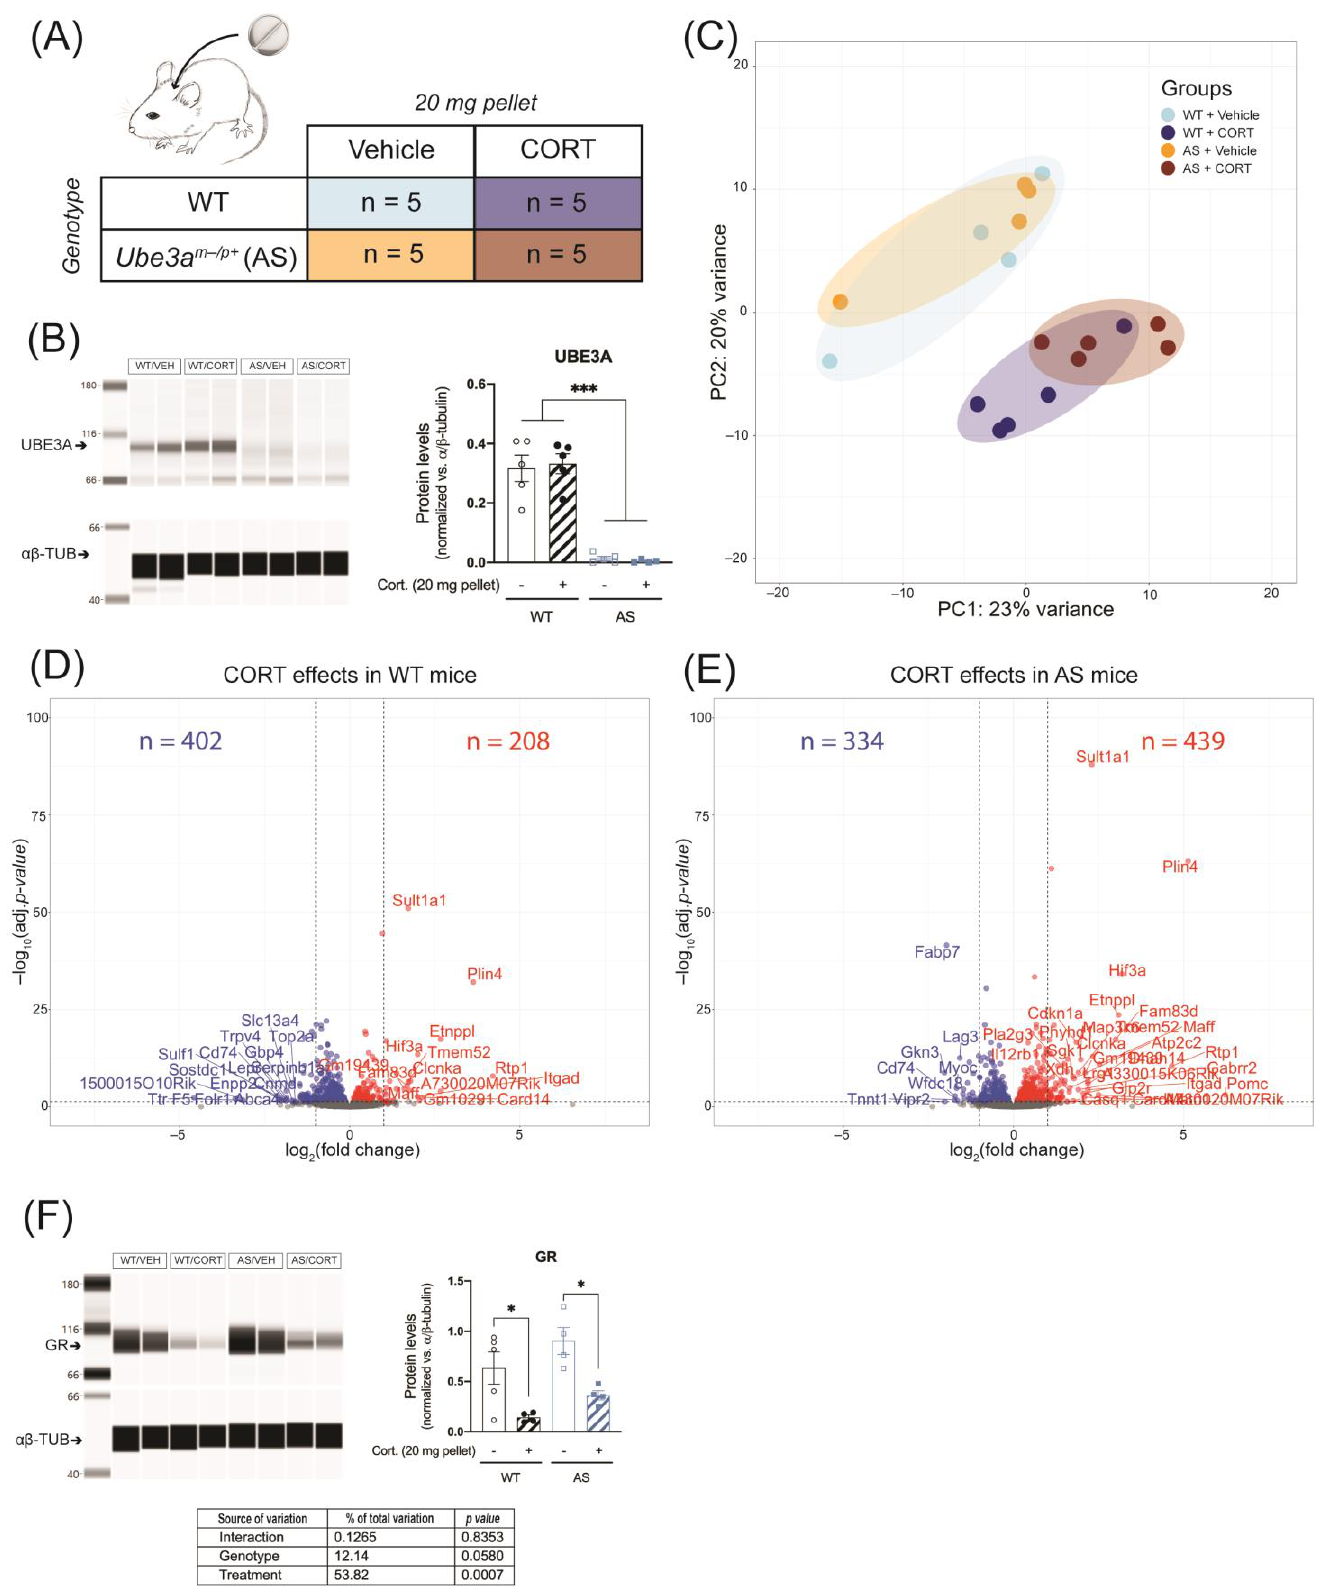
Figure 5. Continuous corticosterone exposure does not differentially alter hippocampal GR signal- ing in UBE3A-deficient AS mice. ( A ) WT and AS mice were subcutaneously implanted with a vehi- cle pellet or a slow-release corticosterone (20 mg) pellet for five days ( n = 5/group). ( B ) UBE3A pro- tein expression in the frontal cortex of WT and AS mice after continuous treatment with vehicle or corticosterone, normalized against αβ - tubulin levels (αβ -TUB). *** p < 0.001. ( C ) Analysis of